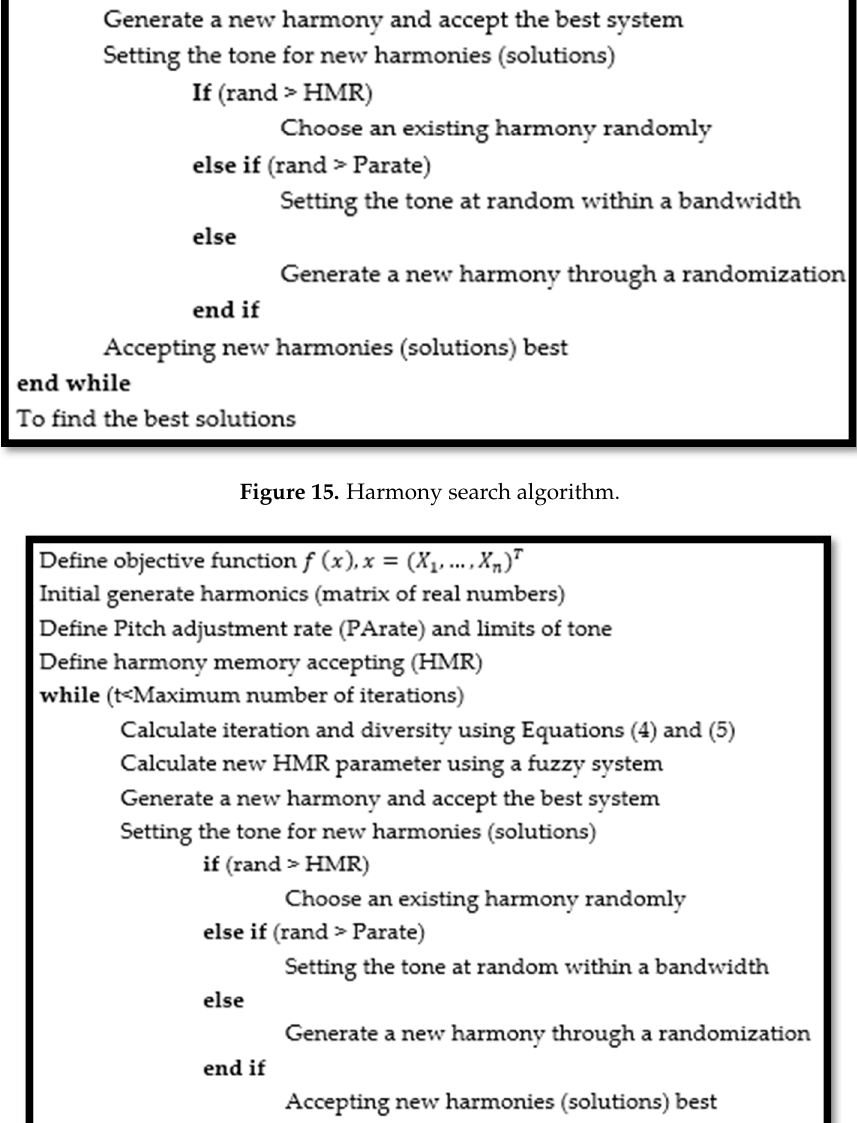
Table 4. Parameters used with the original methods.